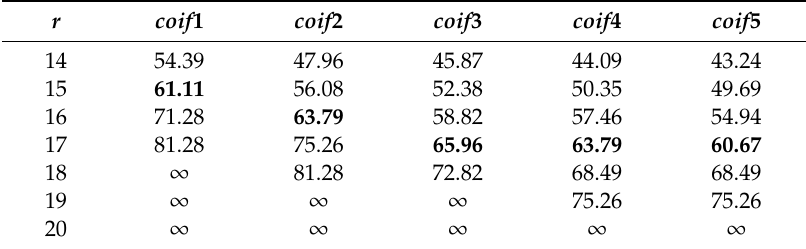
Table 8. Calculation results ( PSNR , dB) of 3D medical images (with 12 BPC) DWT by using bit-width r of coiflets filters coe ffi cients.